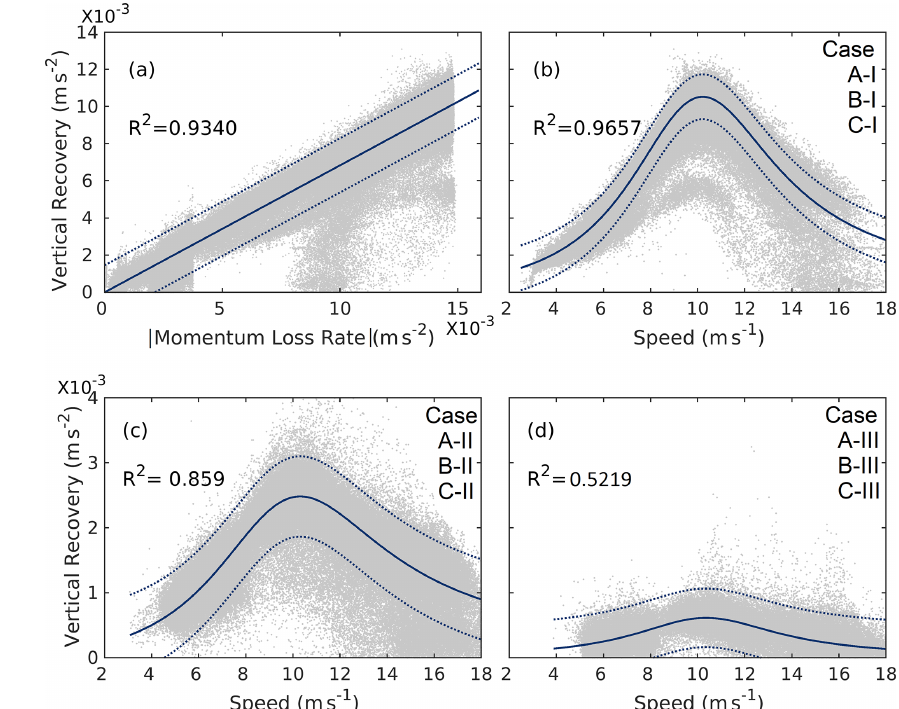
Figure 7. Scatterplot of vertical replenishment with (a) absolute momentum loss rate for all cases and upwind wind speed for (b) case A-I, B-I, and C-I; (c) case A-II, B-II, and C-II; and (d) case A-III, B-III, and C-III. The solid blue line indicates the best fit, and the dashed blue line indicates the 99% prediction intervals. The total number of data points in (a) is 9 × 50 × 50 × 48 and in (b–d) is 3 × 50 × 50 ×